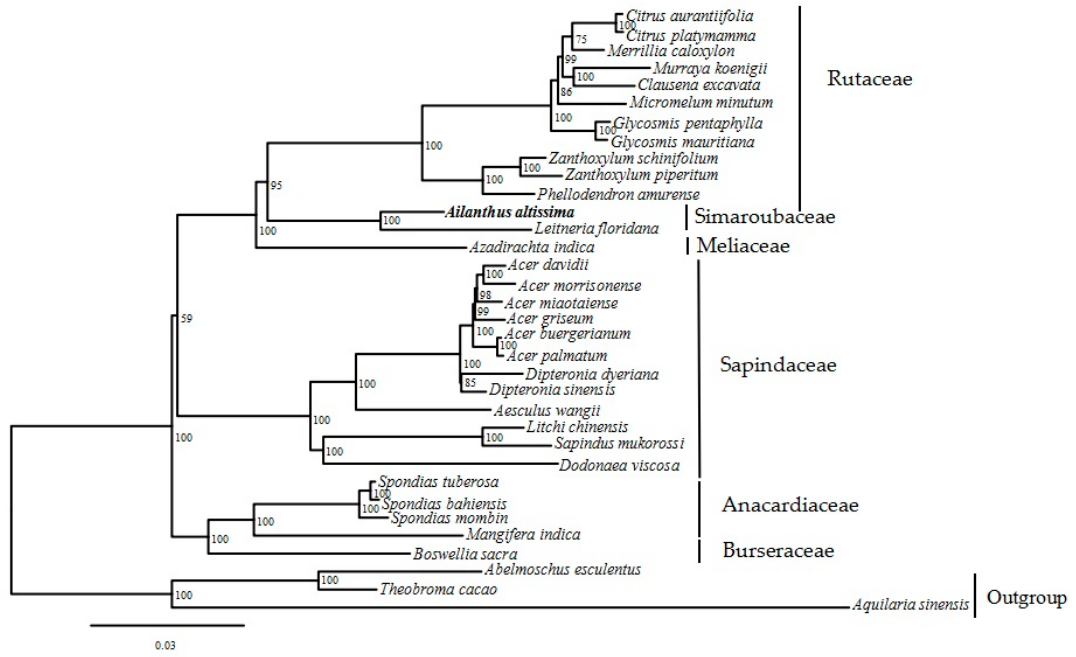
Figure 6. Phylogenetic tree of 31 Sapindales species with three outgroup Malvales species inferred from ML (Maximum likelihood) based on common protein coding genes. The position of A. altissima is shown in bold, while bootstrap support values are shown at each node.